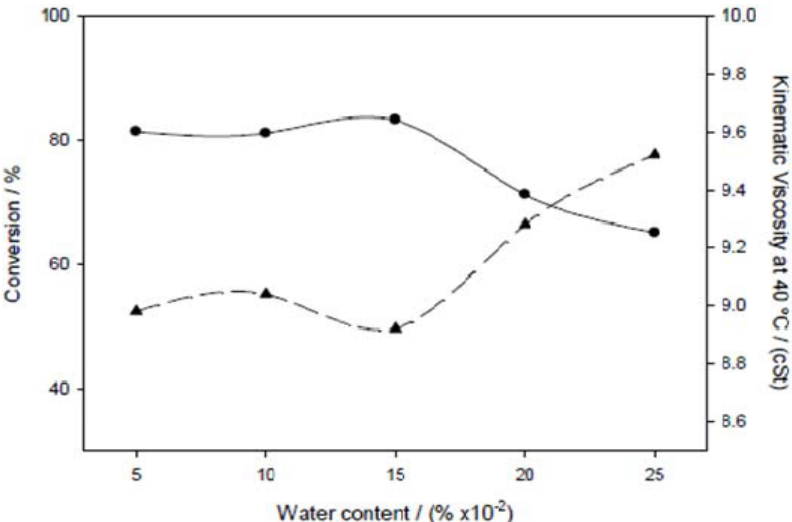
Figure 2. Influence of water content on ethanolysis reaction yield. Conversion ( ● ) and kinematic viscosities ( ▲